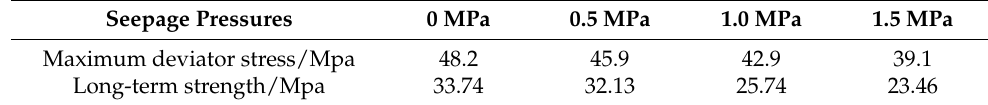
Table 2. The long-term strength under different seepage pressure. Seepage Pressures